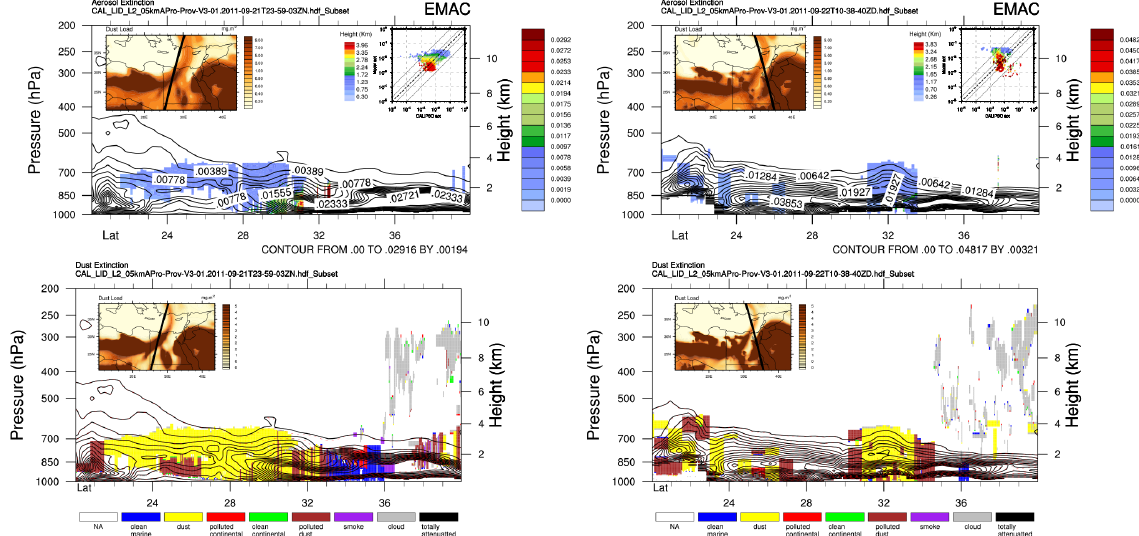
Figure 11. Collocated EMAC calculations and CALIPSO observations of extinction and dust load for two different CALIPSO tracks dur- ing the first dust outflow event – overpasses from Africa to the EM, (top) dust extinction (bottom) CALIPSO aerosol classifications, dust extinction (black line) and total extinction (brown dotted line).